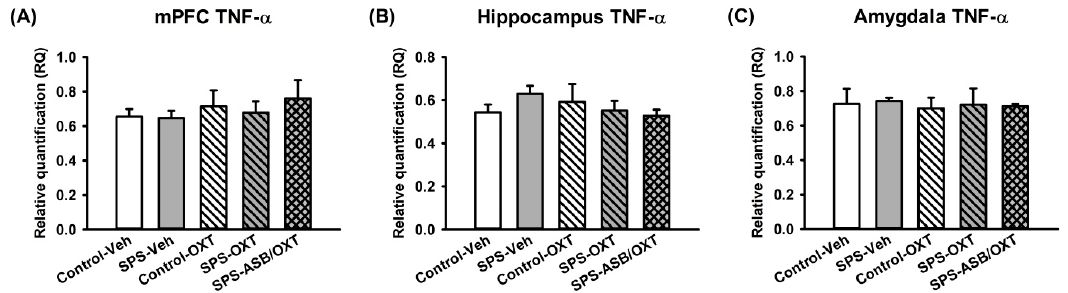
Figure 5. The SPS paradigm and drugs treatment had no effect on the TNF- α mRNA levels in the mPFC, hippocampus, or amygdala ( A – C ). n = 5 for each group; SPS: single prolonged stress, Veh: vehicle, OXT: oxytocin, ASB: atosiban. Bars represent mean ± SEM.